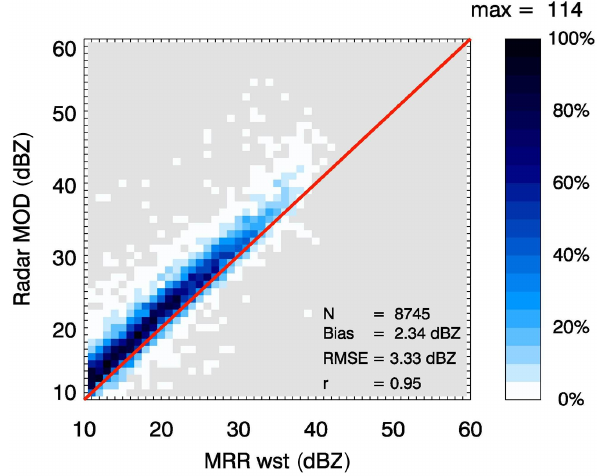
Figure 8. Comparison of X-band radar MOD (ordinate) to micro rain radar WST (abscissa) for April to October 2013. Frequency relative to the highest frequency is shown in different colours, from low levels in light blue to high levels in dark